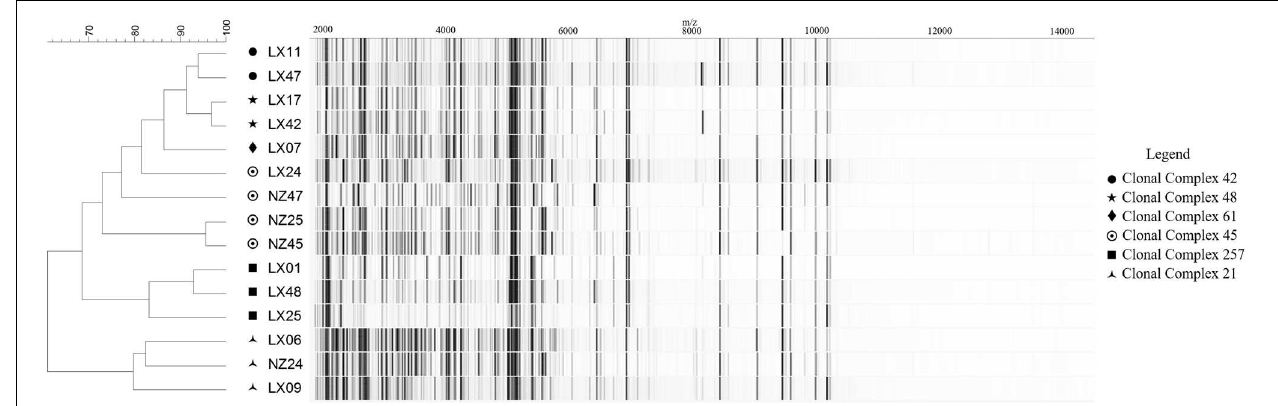
FIGURE 1 | MALDI-TOF MS spectra-based clustering of the Campylobacter jejuni reference strain collection conforming to the genetic fingerprints. Spectra are represented as pseudo-gels. Calculations and clustering were obtained using default settings in the BioNumerics 7.1. Genomic profiles are expressed as Clonal Complexes (CC) obtained through the standardized Multi-Locus Sequence Typing (MLST) method of Jolley and Maiden (2010).